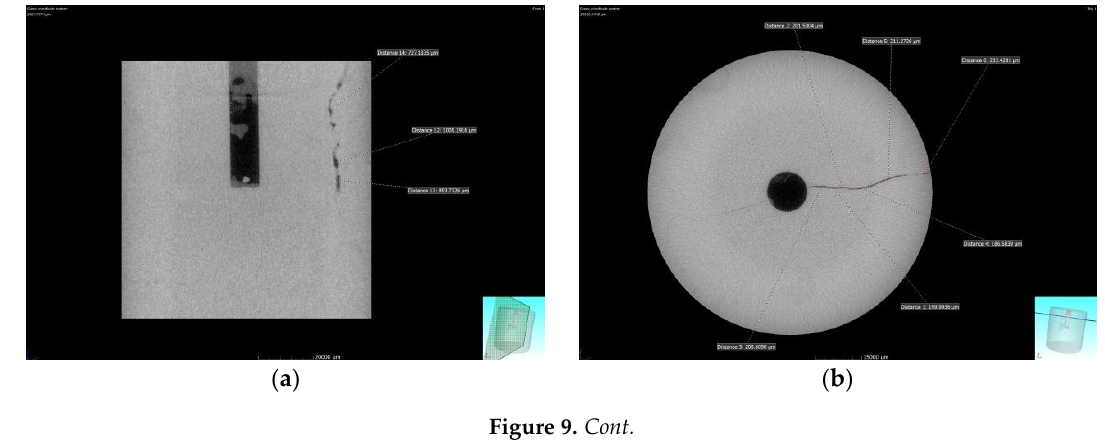
Figure 8. Fracture morphology after hydraulic fracturing of specimen using slick water: ( a ) CT scanning along the axis; ( b ) CT scanning perpendicular to the axis; ( c ) fracture spatial